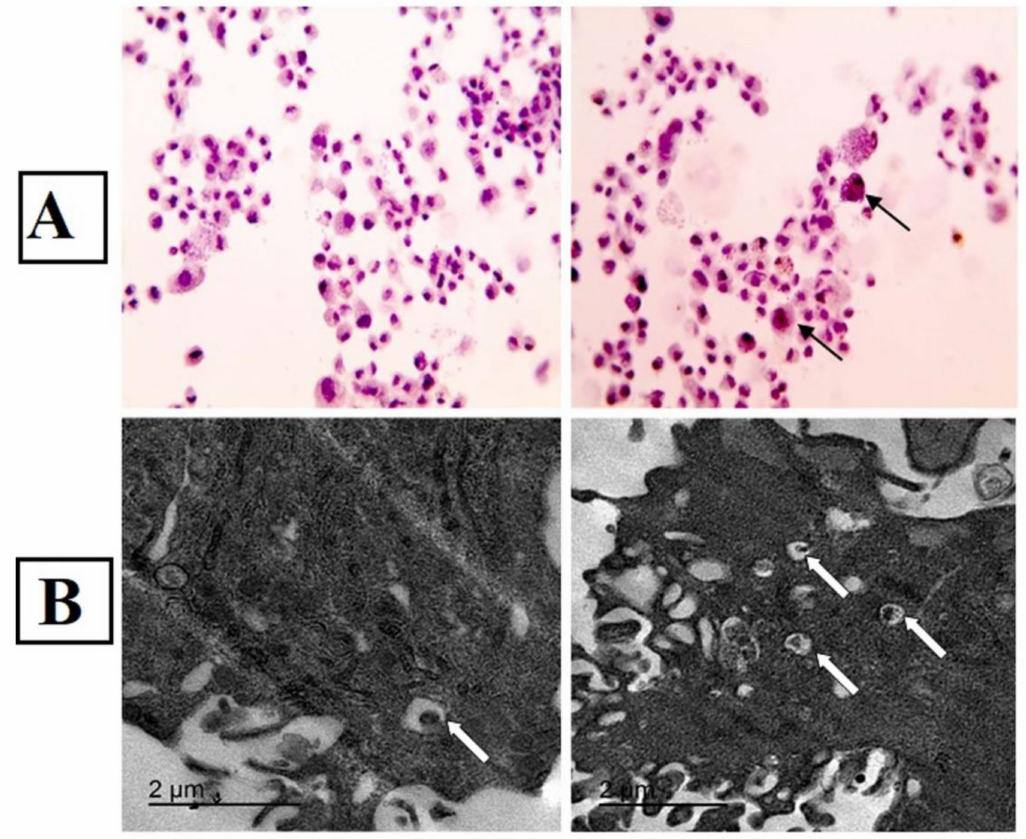
Figure 2. The effect of Rapa treatment on ( A ) LC3 expression using immunohistochemical studies: control ADMSCs against LC-3 show negative staining, and Rapa-treated ADMSCs against LC-3 show increased positive brown intracellular expression (arrows) × 400; ( B ) autophagic ultrastructures. Arrows indicate